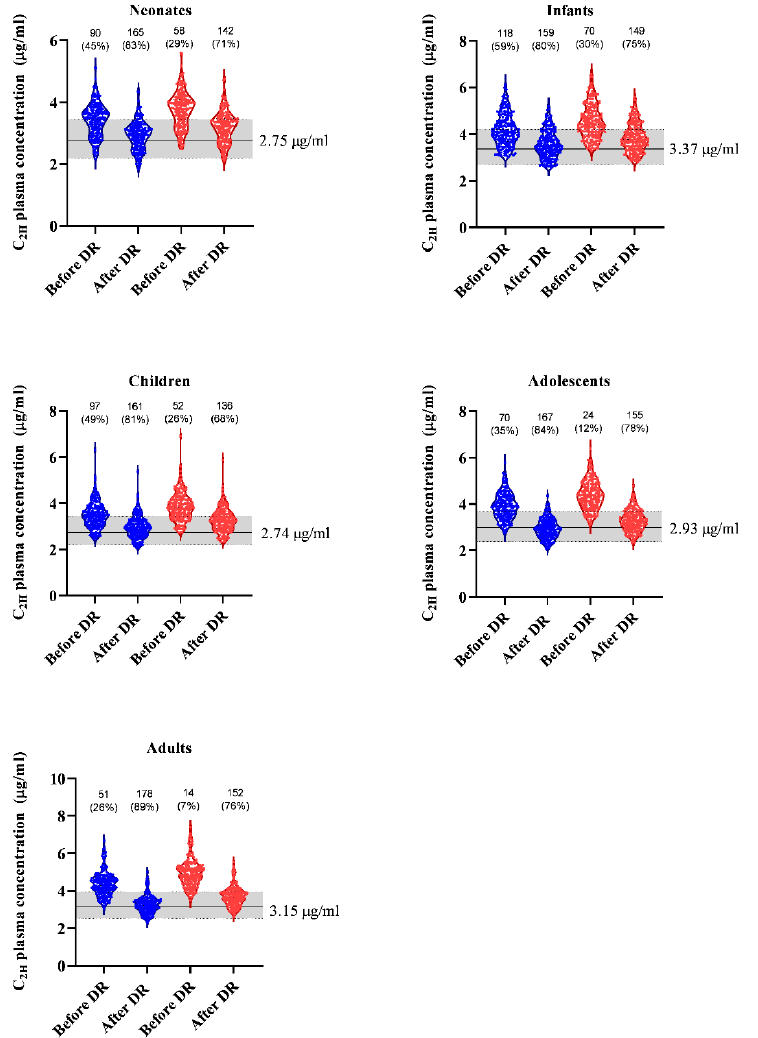
Figure 4. Predicted C 2H concentrations achieved following dosing optimization. Distribution of predicted individual plasma concentrations of propofol at 2 h after start of dosing under 40%-reduced CO conditions (blue plots) and 50%-reduced CO conditions (red plots). The black line is the mean concentration under normal CO conditions and the grey shaded area bordered by a thin black dashed line is the target concentration range. DR: dose reduction.